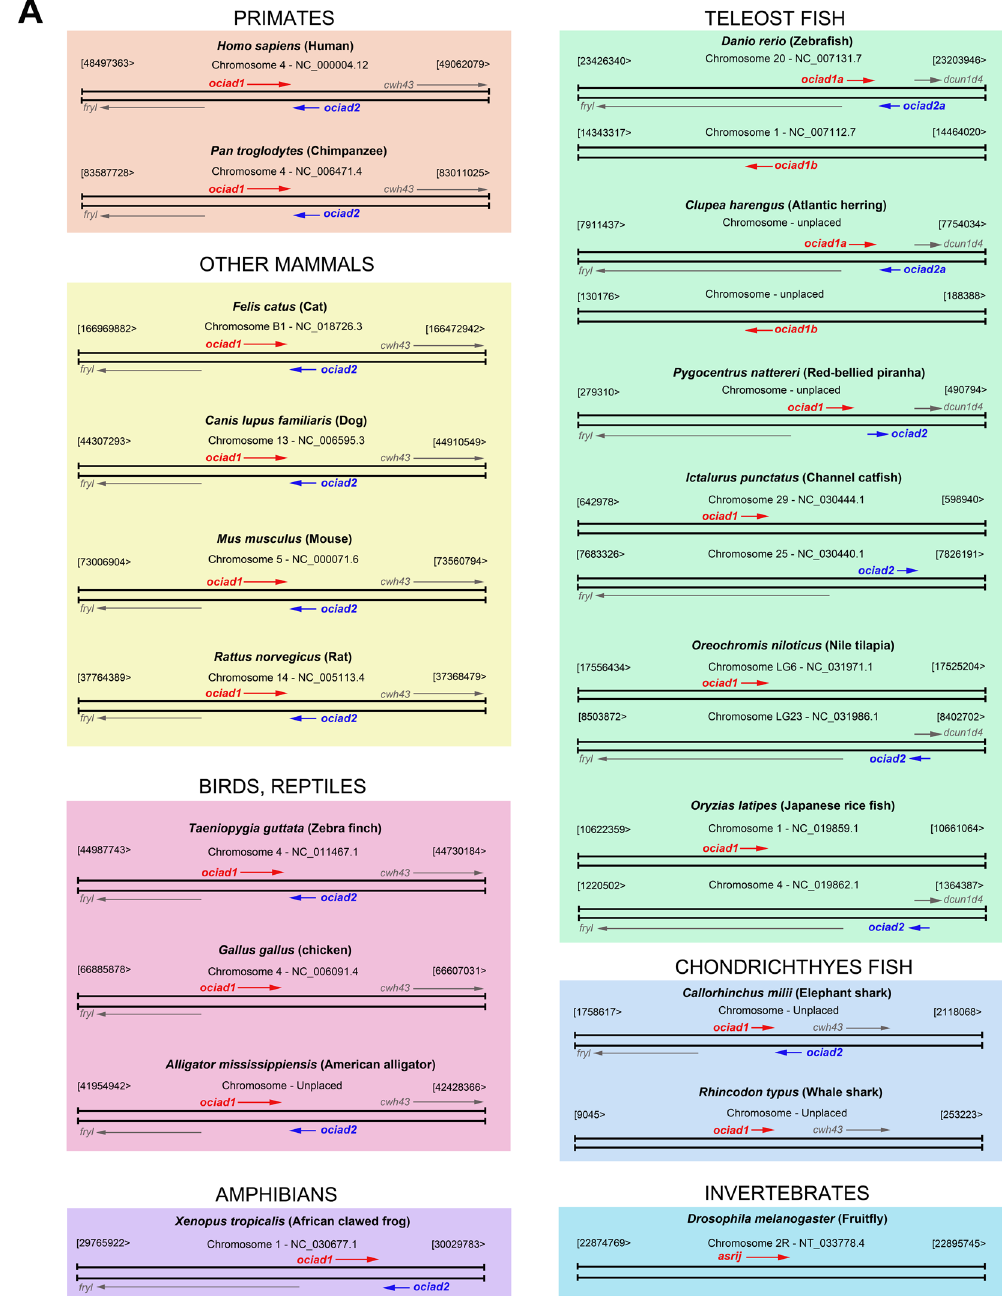
Figure 1. Comparison of the genomic organization for ociad1 and ociad2 across different species. Schematics depict genomic region encompassing ociad1 (red) and ociad2 (blue) and flanking genes fryl , cwh43 or dcun1d4 as indicated. Chromosome numbers and position of genes on sense or antisense strand are indicated. Direction of arrows indicates direction of transcription. Phyla are grouped into colored